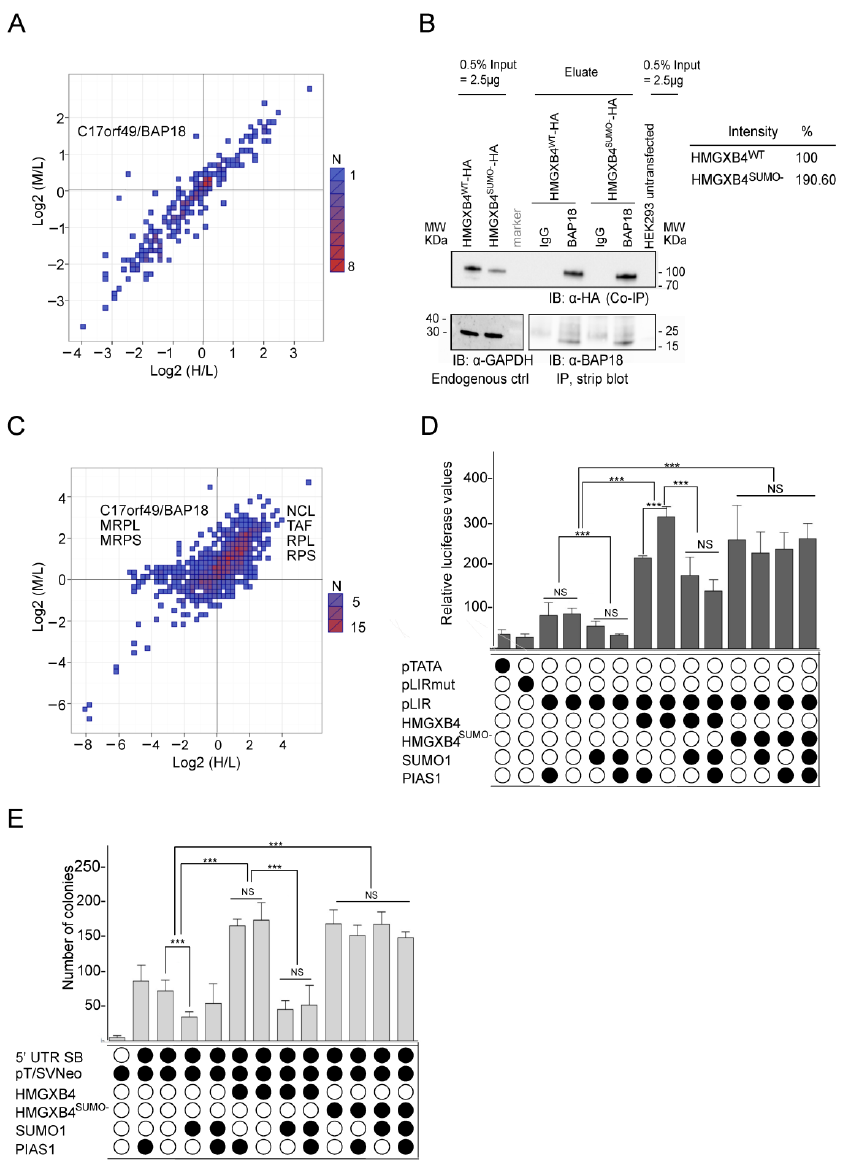
Figure 2. SUMOylation Interferes with the Transcriptional Activator Function of HMGXB4. ( A ) SILAC on HMGXB4 pull-down shows the interactome of SUMOylated and non-SUMOylated versions of HMGXB4 from HEK293 cells. Scatter diagram showing the comparison between the two conditions. The X -axis represents the Log2-fold change of SUMOylated HMGXB4 vs. controls (H/L), whereas the Y -axis represents the Log2-fold change of non-SUMOylated HMGXB4 vs. controls (M/L). See Figure S2C for the experimental design and the description of Heavy, Medium and Light conditions. Note that C17orf4/BAP18 is detected in the interactome of the non-SUMOylated HMGXB4. ( B ) Representative co-immunoprecipitation to validate HMGXB4 and C17orf49/BAP18 interaction in HEK293 cells. (Right panel) Quantification of the intensity signals. Note that while